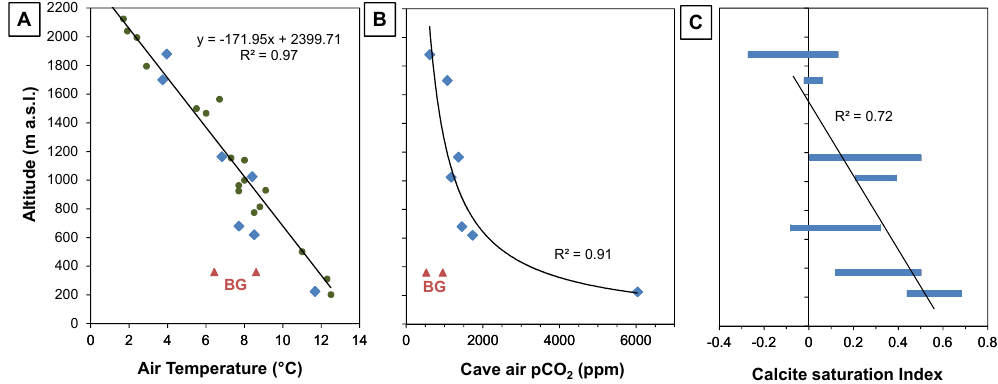
Fig. 2. Temperature, p CO 2 and calcite saturation index with altitude. (A) Air temperature of meteorological stations and cave interiors against altitude. Green dots indicate average air temperature at 2m over the period 1961–1990 at 19 weather stations in Trentino (www. meteotrentino.it). Blue diamonds represent the air temperature of the stable interior cave air for each of the caves (except BG) at the time of sampling. Bigonda Cave (BG red triangles; summer and winter range) falls below the expected temperature for the elevation of the cave entrance. (B) Cave air carbon dioxide concentration in main sampling chamber against cave entrance altitude. BG cave (red triangles) results are excluded from the trend. (C) Dripwater calcite saturation index ranges (Table 1) taken from previous long-term monitoring programs